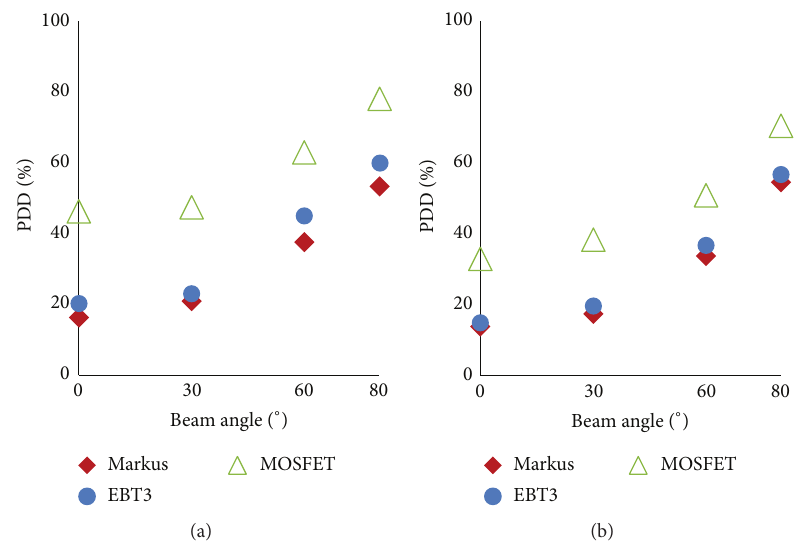
Figure 6: Percentage depth doses (PDDs) for 6 MV (a) and 15 MV (b) measured with Markus chamber, EBT3 film, and MOSFET detector, respectively, at the phantom surface for normal and oblique incident beams.